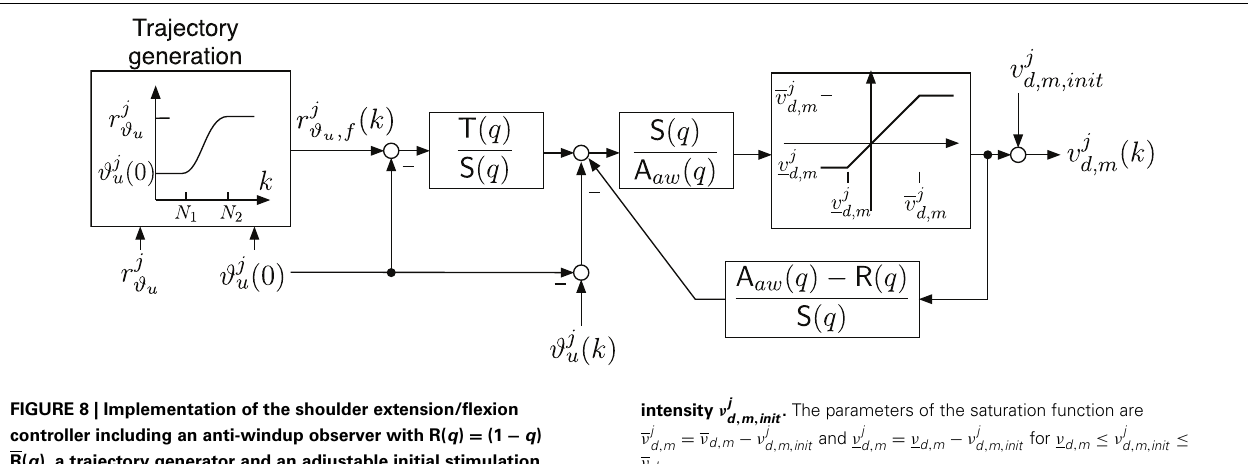
intensity ν j . The parameters of the saturation function are d , m , init ν j = ν − ν j ν j = ν − ν j ν ≤ ν j ≤ d , m d , m d , m d , m d , m , init and d , m d , m , init for d , m , init ν d , m